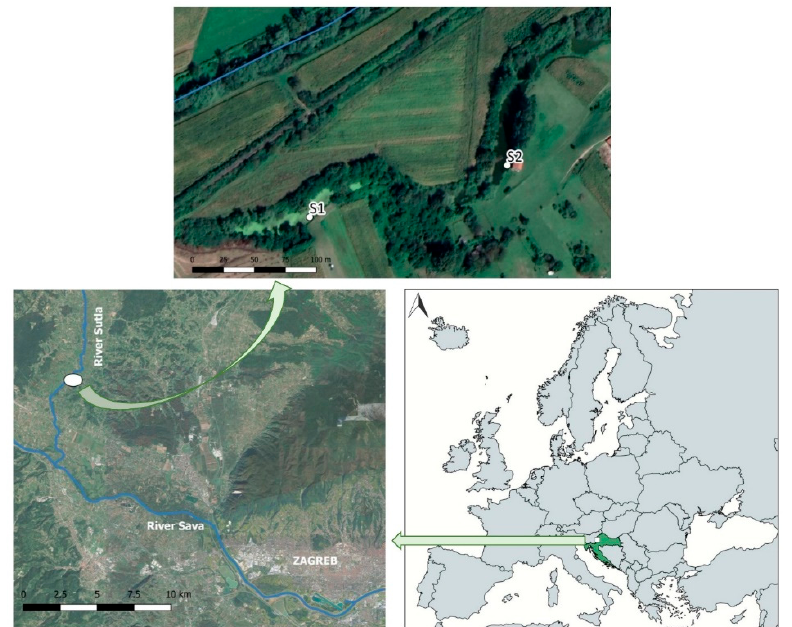
Figure 1. Map with the location of the two studied shallow water bodies of the Sutla River backwater (S1—with submerged macrophytes covered littoral and S2—without macrophytes) and the ground- plan of the investigated water bodies with marked positions of sampling points in the littoral zone.